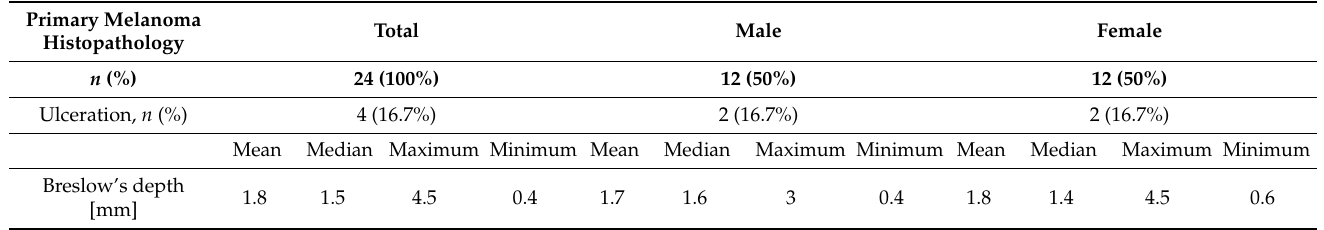
Table 2. Histopathological parameter of the primary melanoma, gender